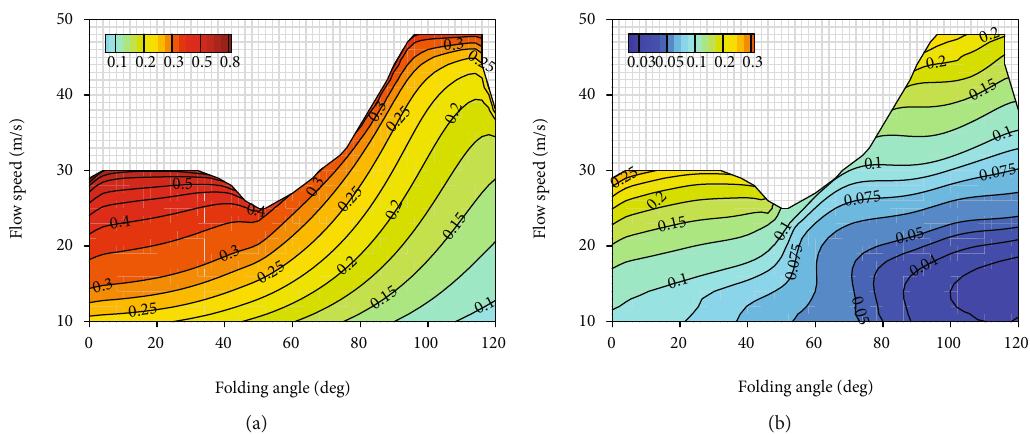
Figure 16: H -norm comparison of the (a) open-loop and (b) closed-loop systems in the design parameter 2